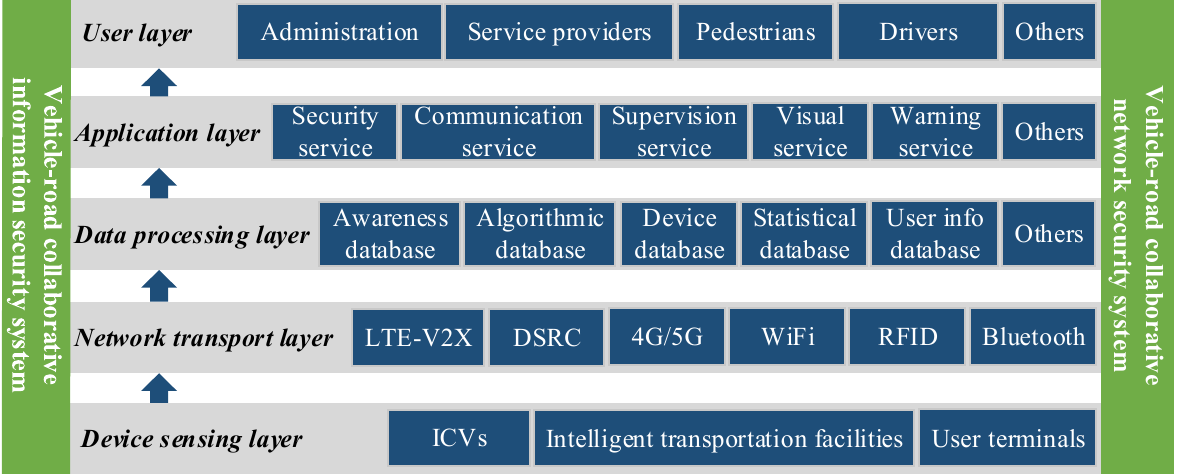
Figure 9. Experimental Area. 4.1. Conceptual Model Development 4.1.1. Extended CWS from the Perspective of Smart PSS In terms of composition, the stakeholders mainly include the relevant management departments, the drivers, and the pedestrians, as shown in Figure 10. The intelligent prod- uct system includes ICVs, roadside equipment, cloud platform, data acquisition equip- ment, etc. The collision-warning service system provides services of security, communi- cation, supervision, visualization, and warning. In particular, the supervision service monitors the running status of vehicles and roadside equipment for the release of im- portant information and vehicle scheduling, which play a crucial role in the entire system.